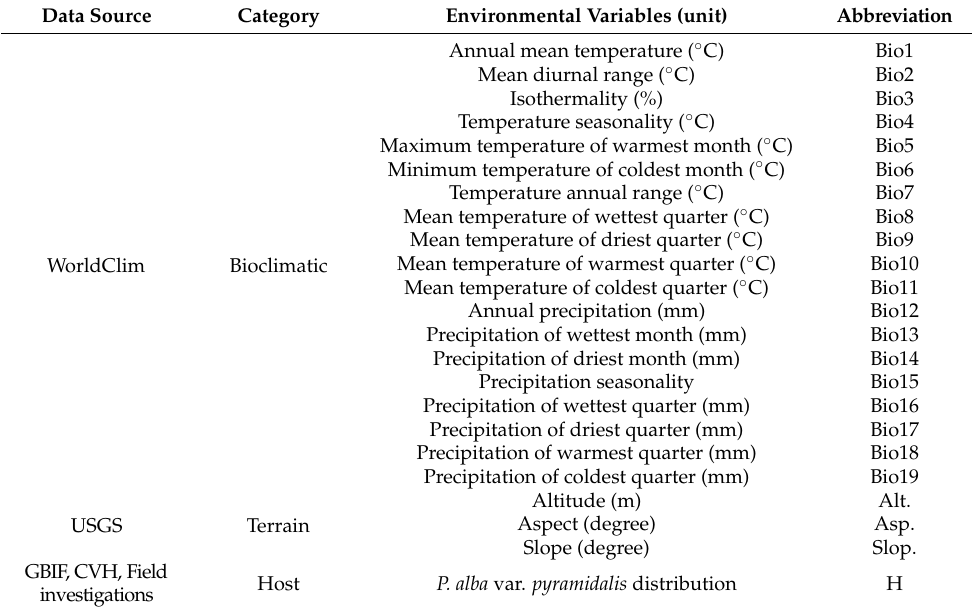
Table 2. Description of environmental variables used for